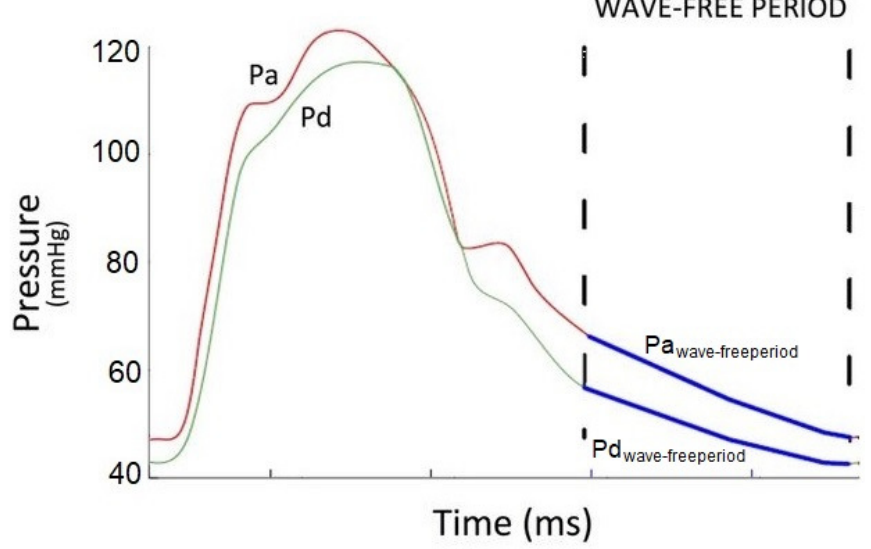
Figure 5. Instantaneous wave-free ratio (iFR) as the ratio of the distal coronary pressure to the pressure in the aorta over a specific period in